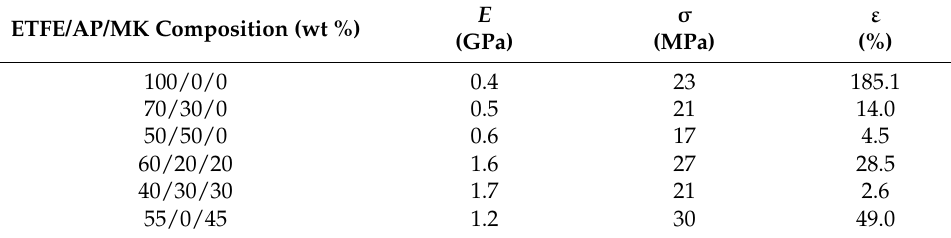
Table 5. Mechanical properties of the composites (the average standard deviation was ± 12%). ETFE/AP/MK Composition (wt